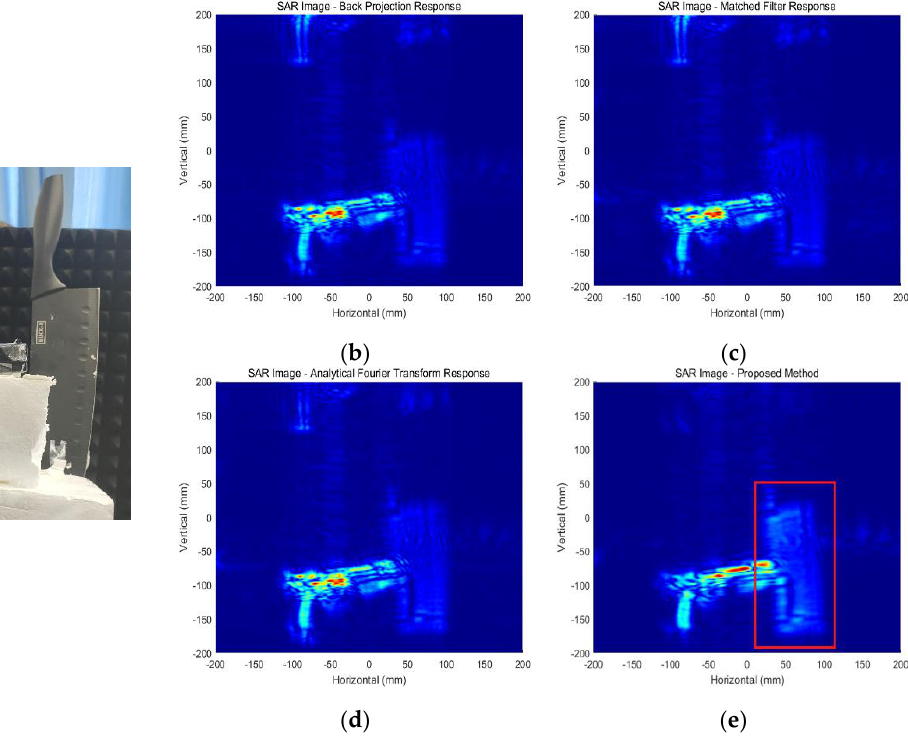
Figure 15. Different-Distance multiple targets: ( a ) scenario-3; ( b ) Back Projection; ( c ) Matched Filter; ( d ) Analytic Fourier Transform; ( e ) mmSight (red frame: projection of other target).